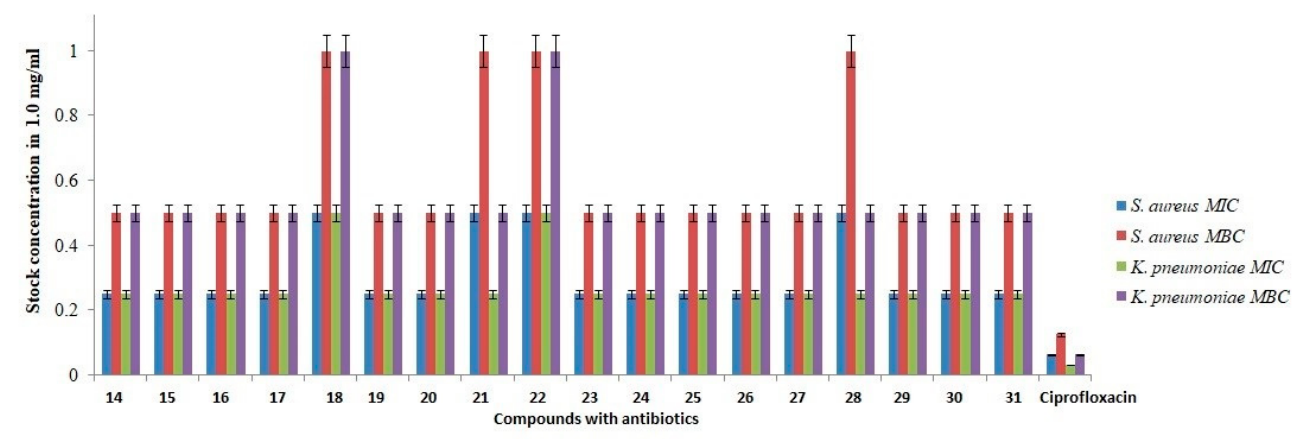
Figure 6. MIC and MBC of pyazolo[3,4- b ]pyridine and triazole molecular